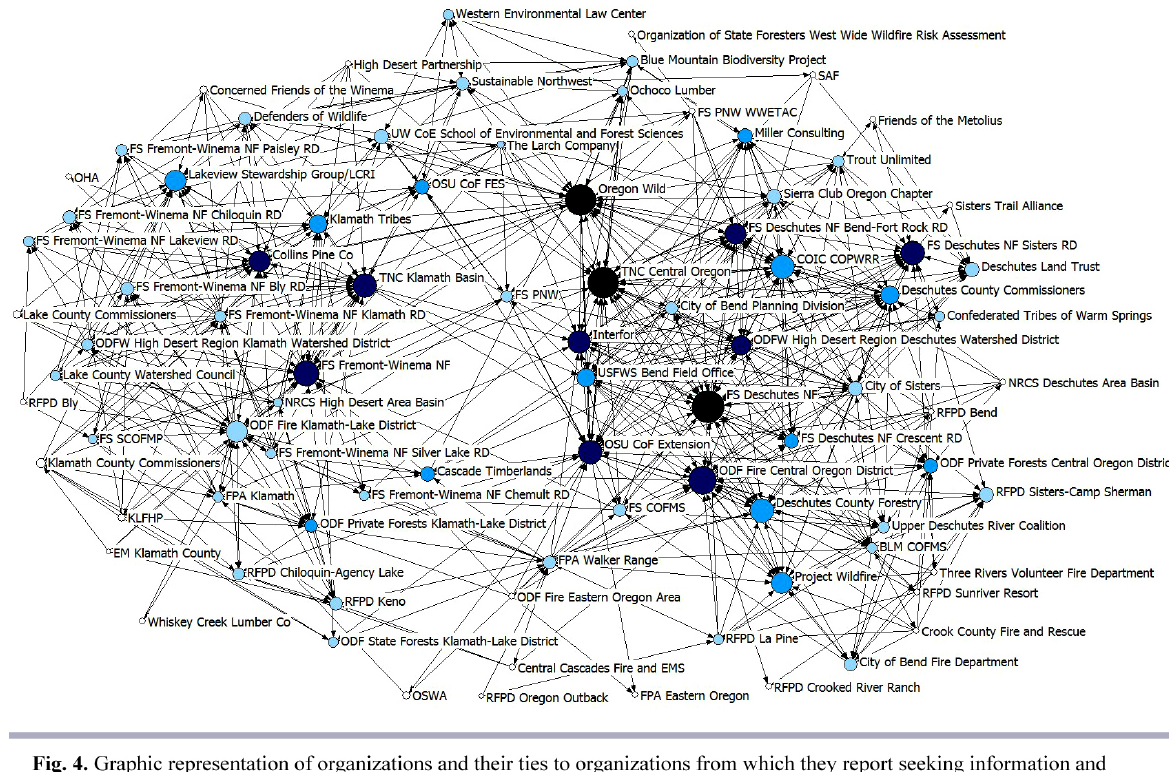
Fig. 3 . Graphic representation of organizations and their ties to organizations with which they report working. Nodes sized by popularity, i.e., larger indicates greater indegree centrality, and shaded by diversity of ties, i.e., darker indicates more heterophilous ego